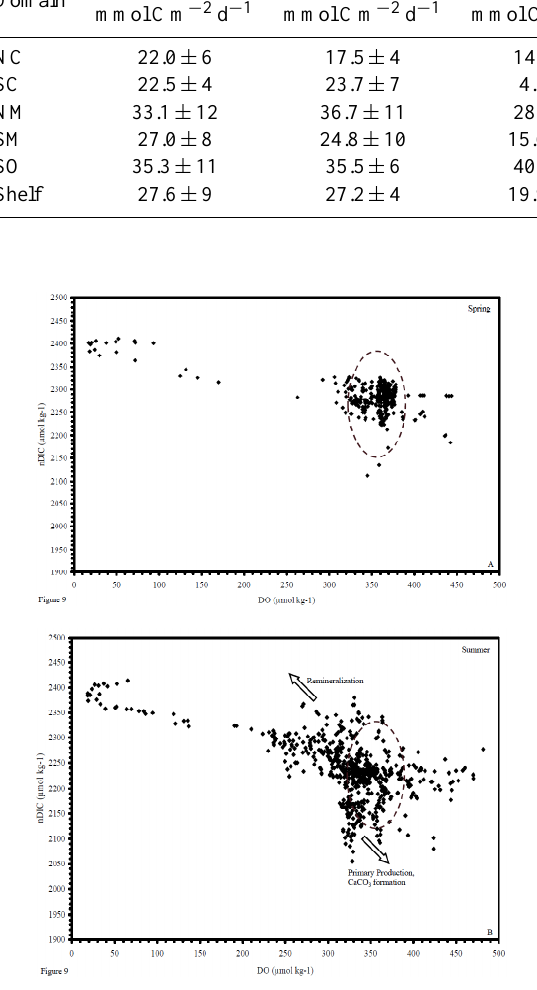
middle domain ( ∼ 2.2 mmoles C m − 2 d − 1 on average), while the correction decreases NCP in the southern coastal do- main ( − 1.1 mmoles C m − 2 d − 1 on average), the northern middle domain ( − 3.6 mmoles C m − 2 d − 1 on average), and the southern outer domain ( − 1.2 mmoles C m − 2 d − 1